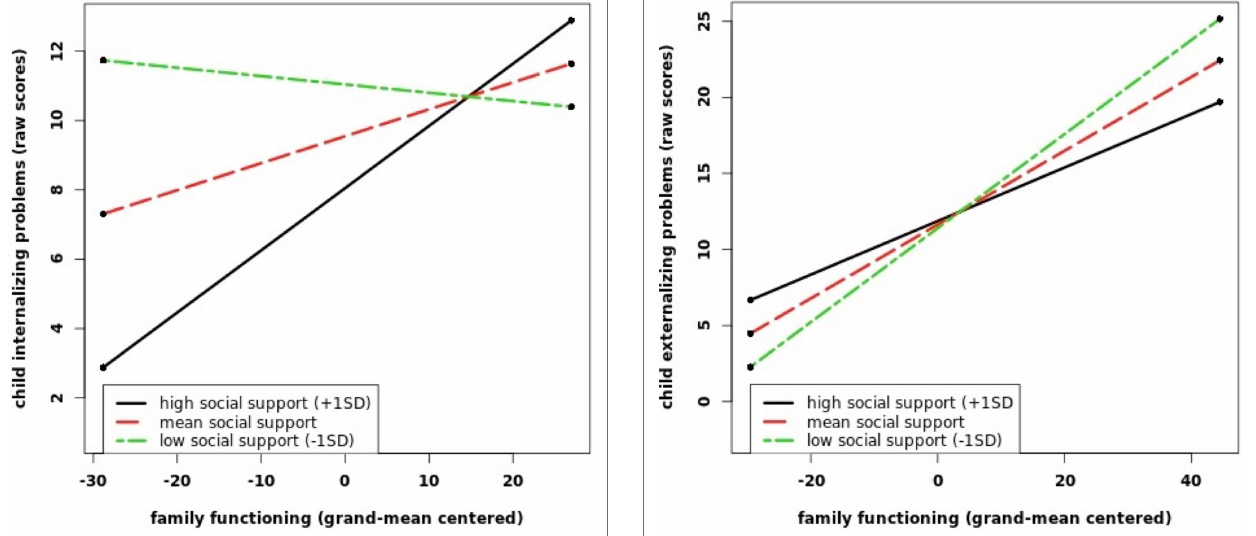
FIGURE 1 | This figure shows the interaction between family functioning (FBA) and social support (OSSS) on child internalizing problems (CBCL) from the partners’ perspective. The values for FBA and OSSS are grand-mean centered.